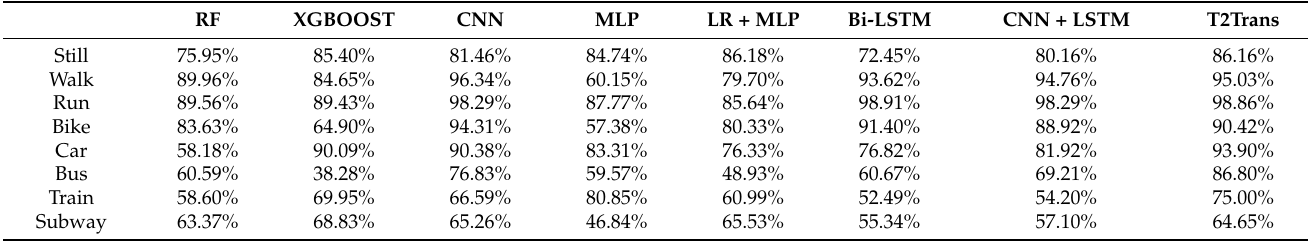
Table 6. Performance comparison between the algorithms of the best teams and the T2Trans algorithm on the SHL dataset for the third SHL recognition challenge.